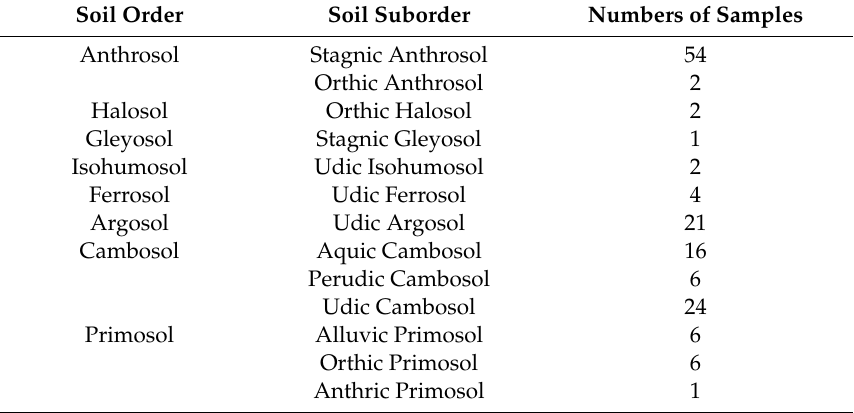
Table 1. Soil orders and suborders classified for 146 soil profiles.